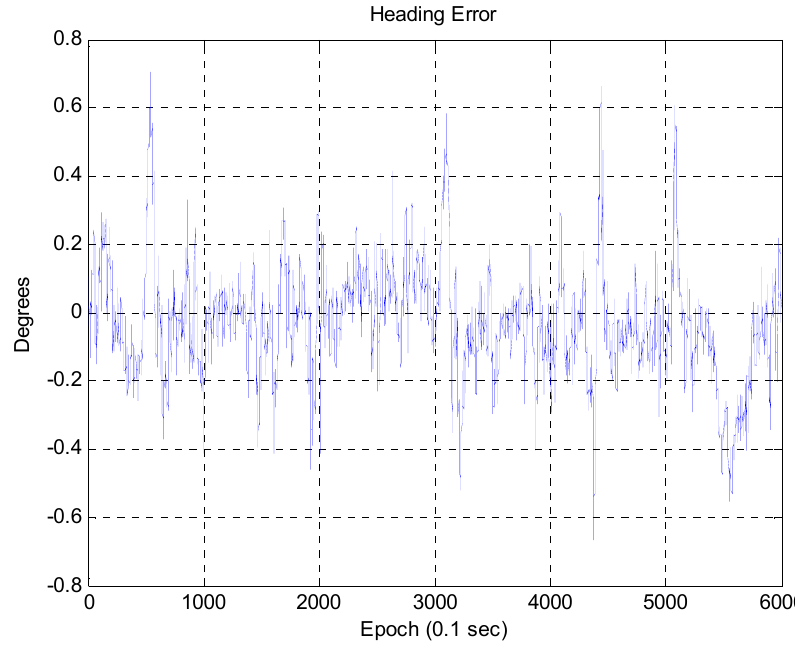
Figure 18. Heading error (corner map matching).